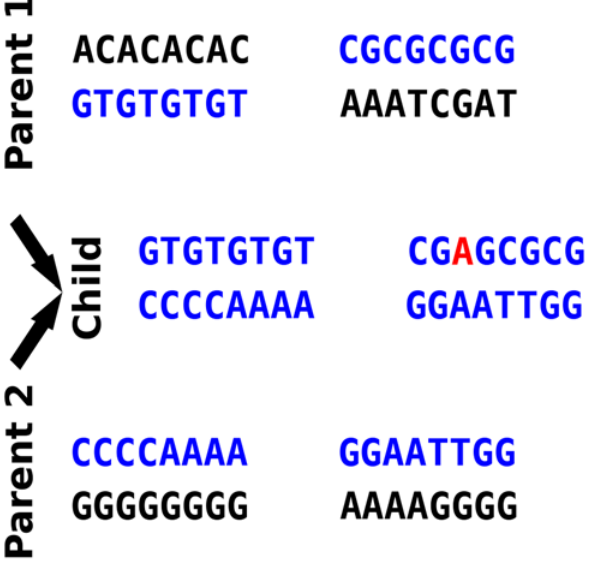
Figure 7. Offspring Survival Probability S as a Function of Genetic Difference H . For all the results presented in this paper, viability is not reduced if gametic genomes differ only by h 0 =0.05 or less (this is an adjustable parameter in the model). If gamete genomes differ by more than 5%, offspring survival probability is reduced linearly to eventually reach 0 for a threshold amount h of genetic difference ( h =0.6 in this graph and in all simulations presented here).